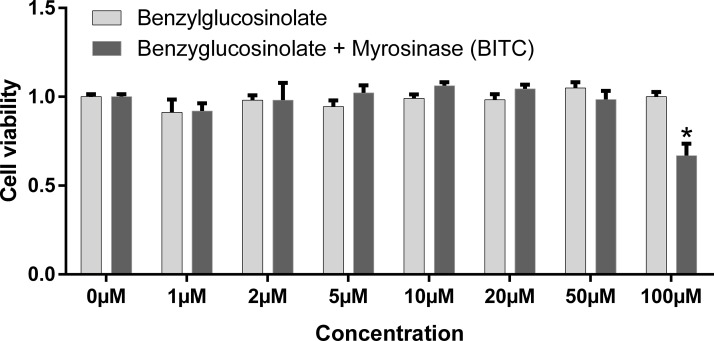
HepG2 cells survival.Following 4 h incubation at 37°C with 20 μM of PMS-electron coupling reagent (3-(4,5-dimethylthiazol-2-yl)-5-(3-carboxymethoxy phenyl)-2-(4-sulfophenyl)-2H-tetrazolium inner salt (MTS)/ phenazine methosulfate, the optical density (OD) of the MTS bioreduction product formazan was measured at 490 nm wavelength. OD mean values were normalized to mock treated cells (100% survival). Mean values + SEM (n = 3) *(p<0.05) significant differences vs control (Oneway ANOVA and posthoc Bonferroni).